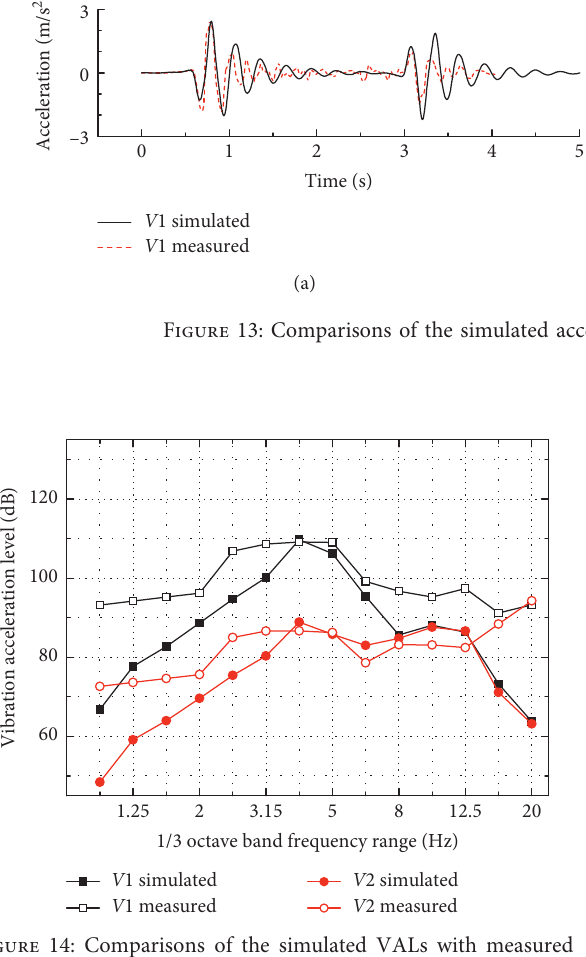
V 2 simulated V 2